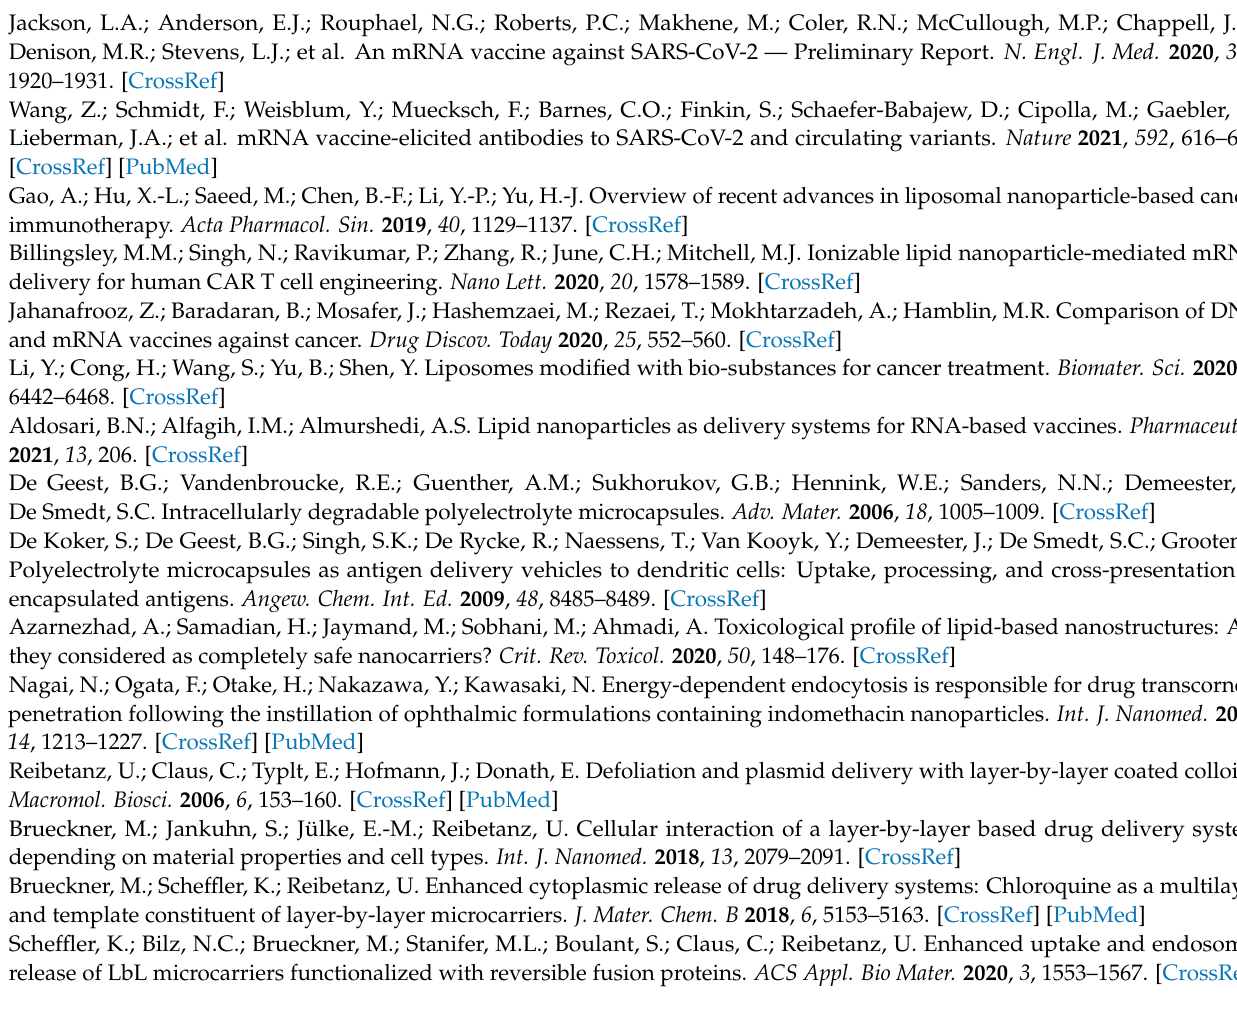
all given cell types after 16 h incubation, Figure S2: Localization of SLB microcarriers in Vero cells. Figure S3: SLB microcarriers (transmission image, c) in Vero cells with mitochondria (red), micro- tubule filaments (green) and nucleus (blue) staining, as seen in overlay (b). Figure S4: Intracellular control staining of SLB microcarriers with mitochondria-specific dye MitoTracker